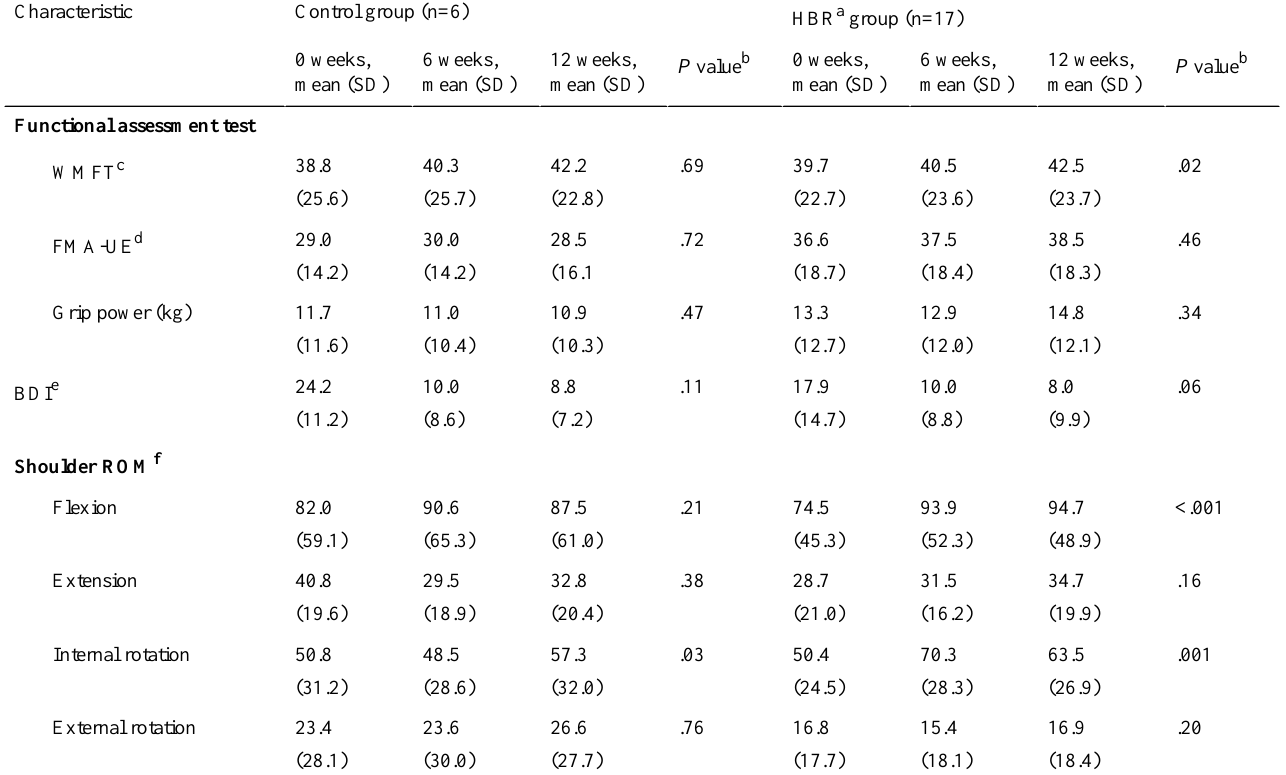
Table 3. Clinical results in the control and home-based rehabilitation groups during the experiment.